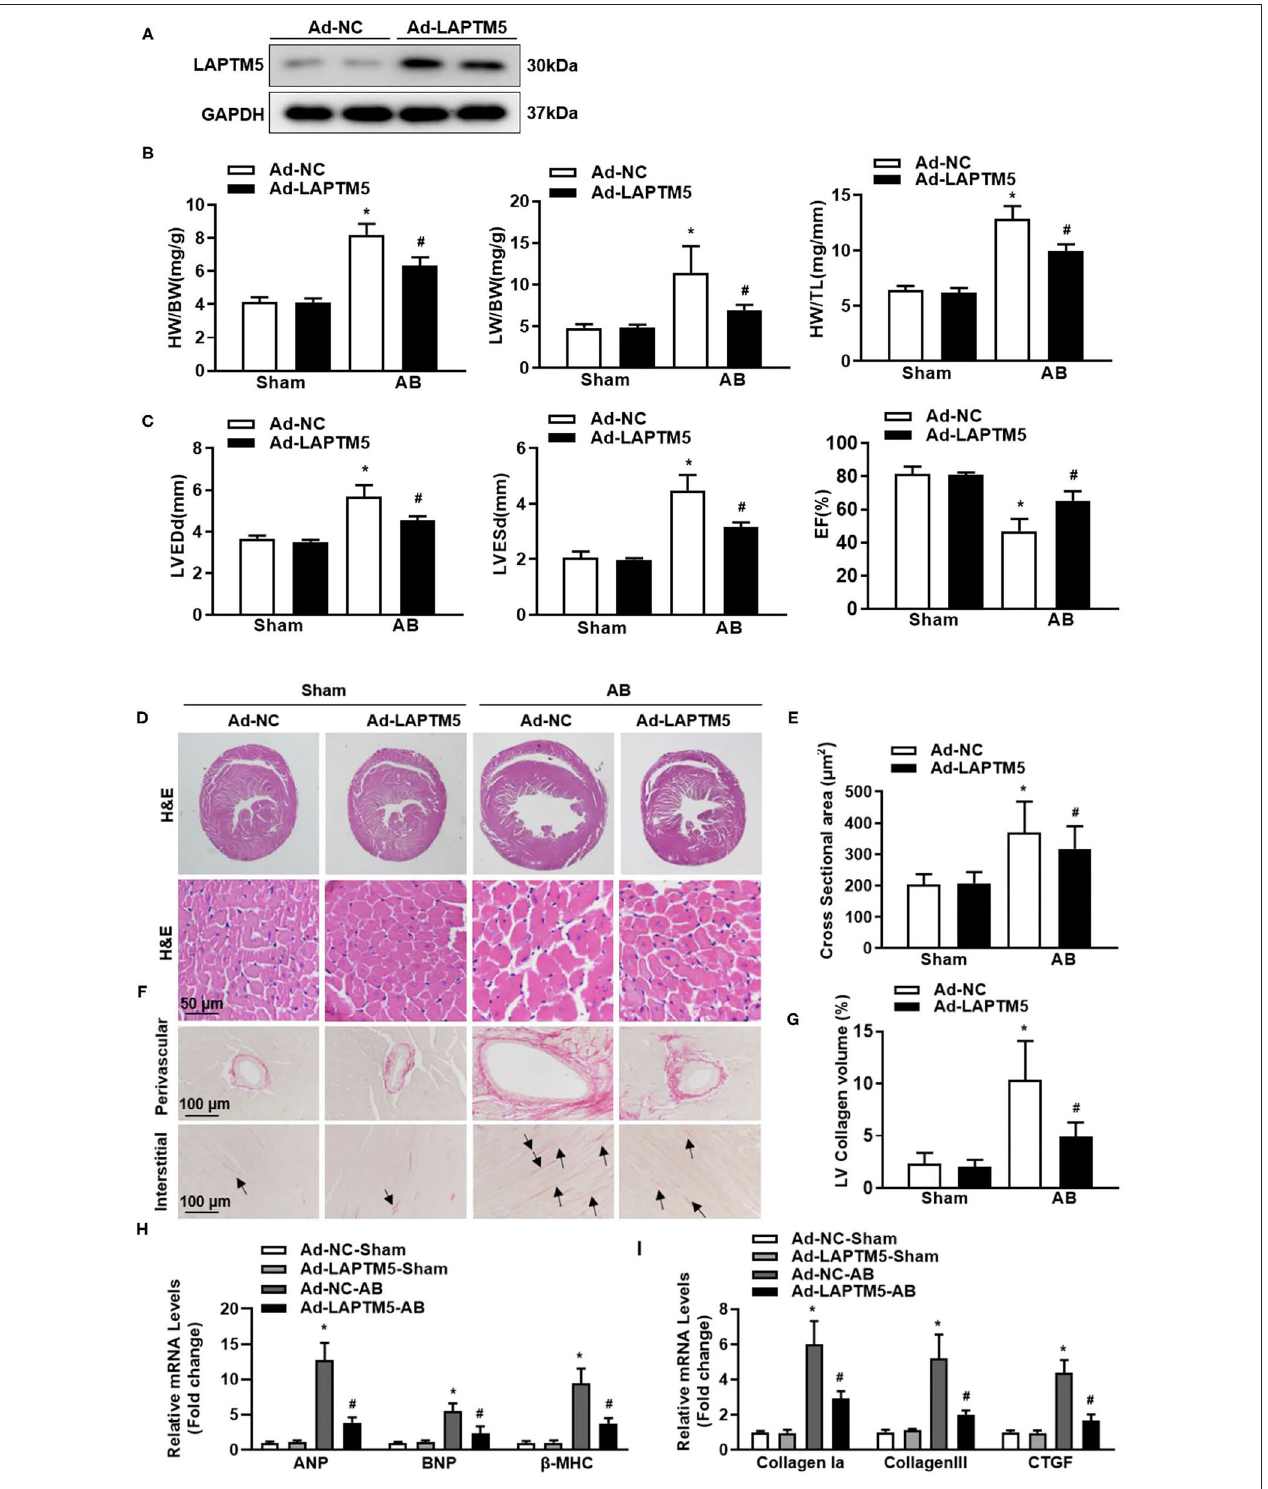
FIGURE 4 | Overexpression of LAPTM5 attenuates AB-induced cardiac hypertrophy. (A) Protein level of LAPTM5 in heart tissue in mice injected with Ad-NC or Ad-LAPTM5 ( n = 3). (B) Heart weight (HW) to body weight (BW) ratio, HW to tibia length (TL) ratio, lung weight (LW) to BW ratio in the indicated groups ( n = 11–15). (C) Echocardiography results in the indicated groups ( n = 8). (D,E) Representative images of H&E staining and the quantitative results ( n = 6). (F,G) Representative image of PSR staining and the quantitative result ( n = 6). (H,I) The mRNA levels of hypertrophic and fibrosis markers ( n = 6) (* P < 0.05 vs. Ad-NC-Sham, # P < 0.05 vs.